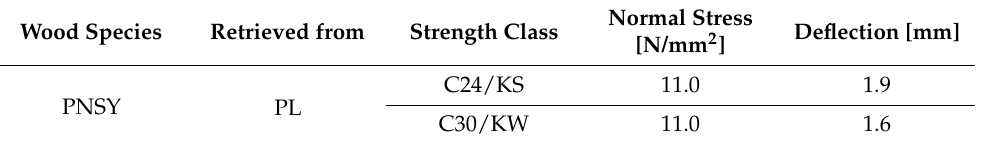
Table 16. Normal stresses and deflection (displacement) of F version short frames made of glued material with a finger-jointed lamella length of 400 mm (pine, country of origin: Poland).